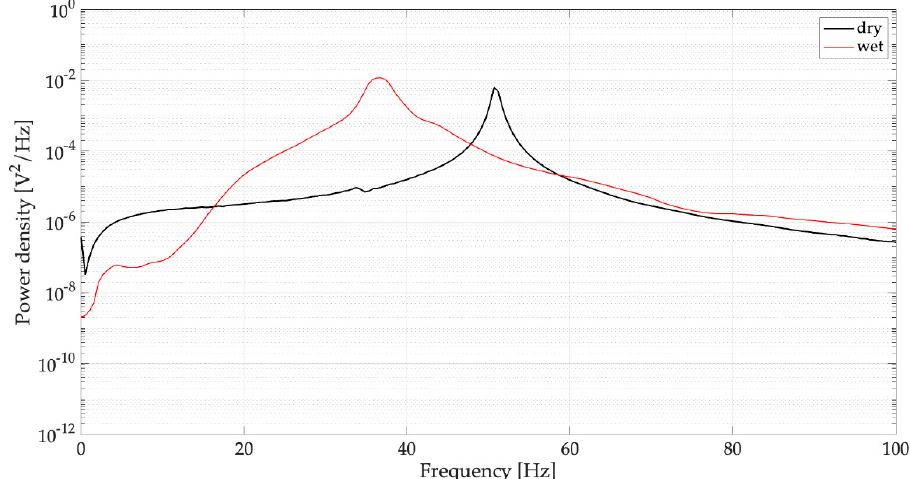
Figure 15. Effect of the filled spoon on the PSDs of open-circuit voltage (dry: harvester with empty spoon, wet: spoon filled with water).